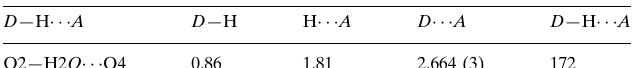
Hydrogen-bond geometry (A˚ , (cid:5)